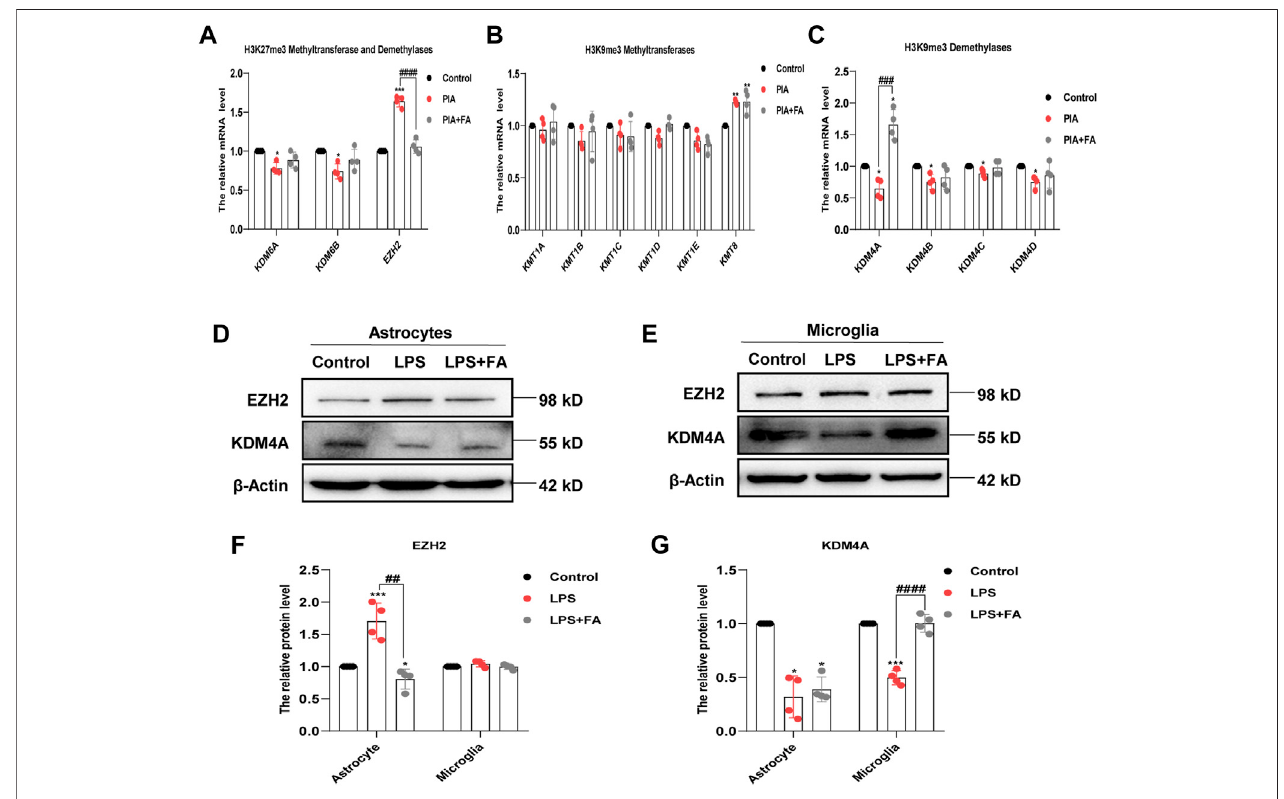
FIGURE 9 | FA regulated different histone methylation modi fi ed enzymes in astrocytes and microglia. (A) Quantitative RT-PCR showed the expression levels of histone H3K27me3 methyltransferase and demethylases. Compared with the PIA group, the mRNA level of EZH2 in the FA-treated group decreased signi fi cantly. (B) Quantitative RT-PCR showed the expression levels of histone H3K9me3 methyltransferases. Compared with the PIA group, there was no signi fi cant change in the mRNA level of histone H3K9me3 methyltransferases after FA treatment. (C) Quantitative RT-PCR analysis showed the expression levels of histone H3K9me3 demethylases.ComparedwiththePIAgroup,themRNAlevelofKDM4AintheFA-treatedgroupincreasedsigni fi cantly. (D – G) Representativeimagesandquanti fi cation of Western blotting analysis of the expression levels of EZH2 and KDM4A in primary astrocytes and microglia. Data: mean ± SEM; * p < 0.05, ** p < 0.01, *** p < 0.001 versus the control group; ## p < 0.01, ### p < 0.001, #### p < 0.0001 versus the PIA group; n = 4 per group (one-way